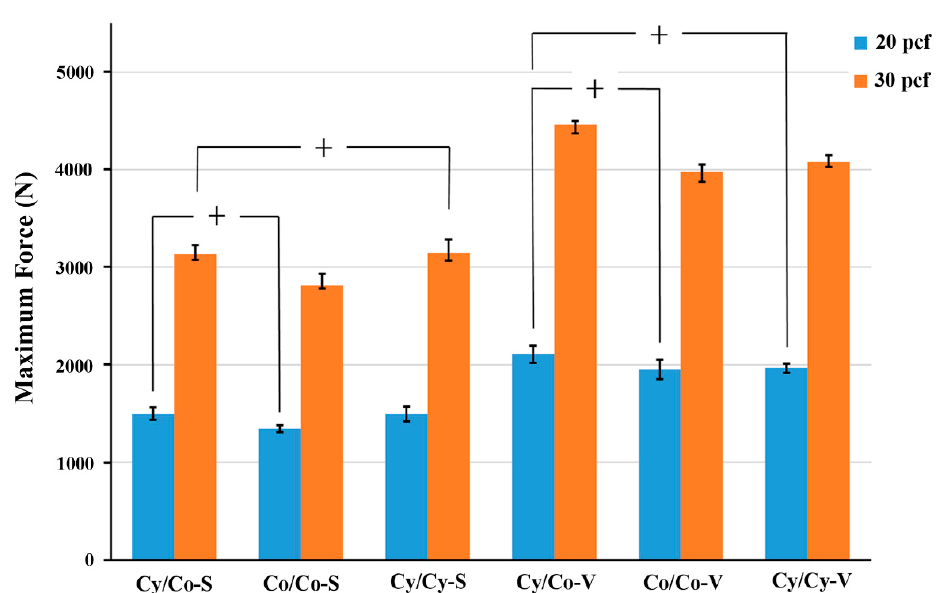
Figure 6. Mean ultimate pullout strength for screws of various geometries inserted in a 3.7-mm pilot hole using 20-pcf and 30-pcf test blocks. Groups without significant differences are indicated with the ‘‘+” symbol.